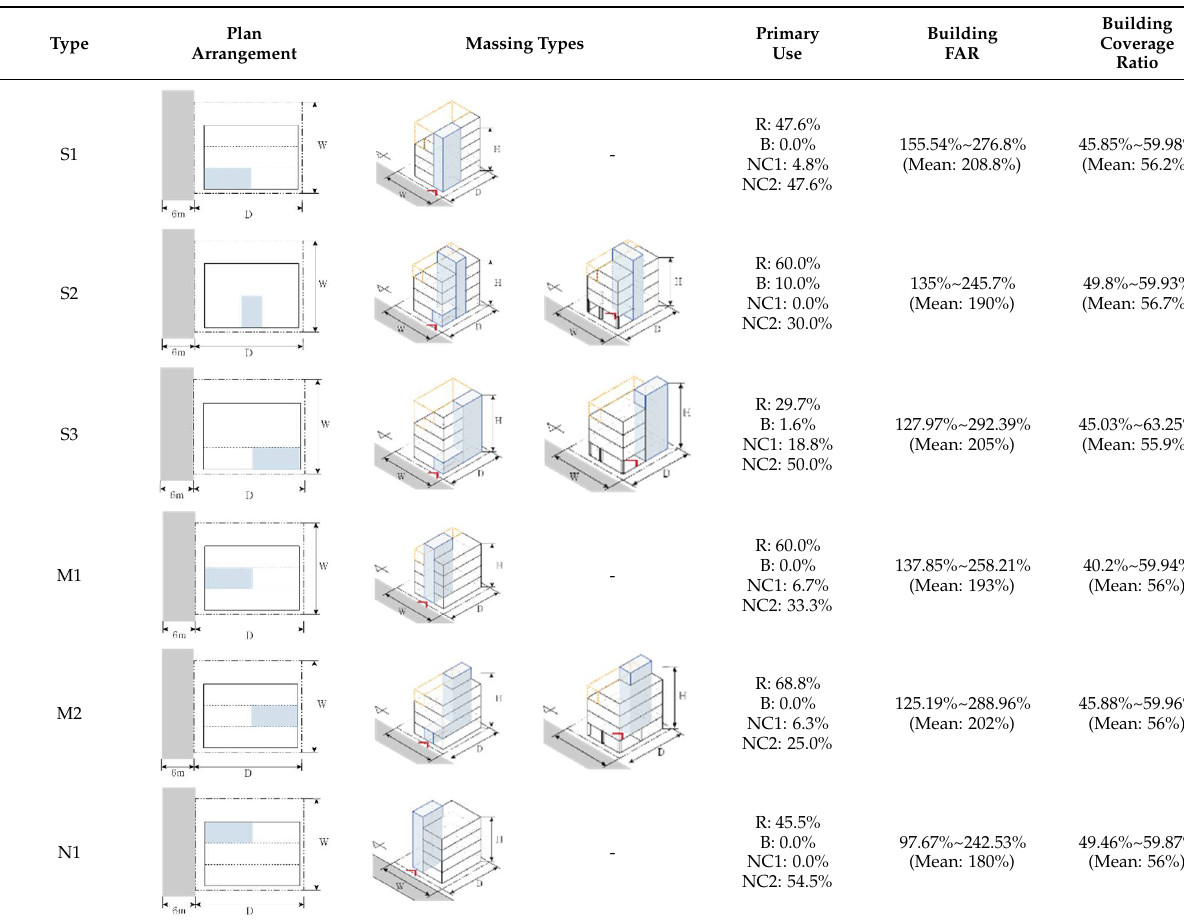
Table 2. Characteristics of massing types.